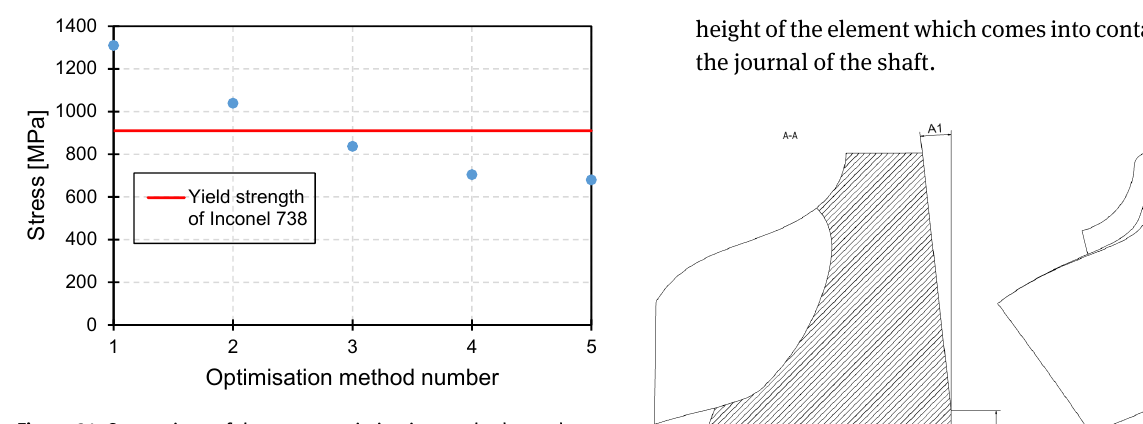
Figure 21: Comparison of the stress optimisation methods used